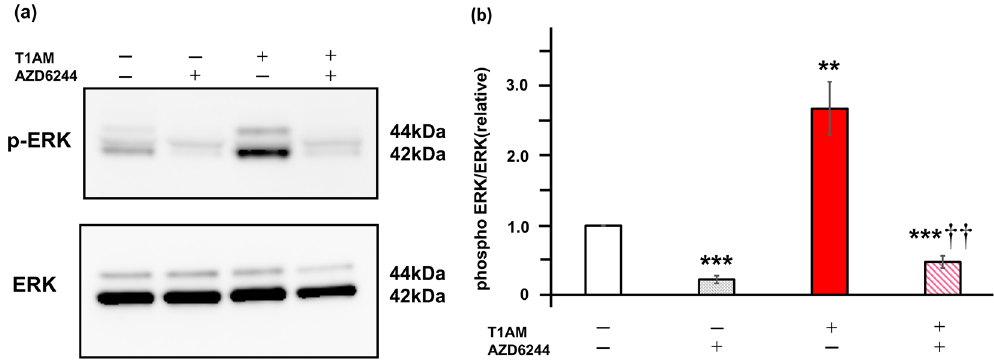
Figure 4. Effects of T1AM on ERK signaling in NRCM. ( a ) Phosphorylation of ERK was evaluated in NRCM treated with or without T1AM (50 μM) stimulated with either AZD6244 (MEK inhibitor, 500 nM) or vehicle for 6 h. Representative immunoblots obtained using the indicated antibodies are shown. ( b ) Averaged densitometry data normalized to the control at the same time points are shown in the bar graphs (n = 5 each). * P < 0.05, ** P < 0.01 and *** P < 0.001 versus untreated control; †† P < 0.01 versus T1AM.